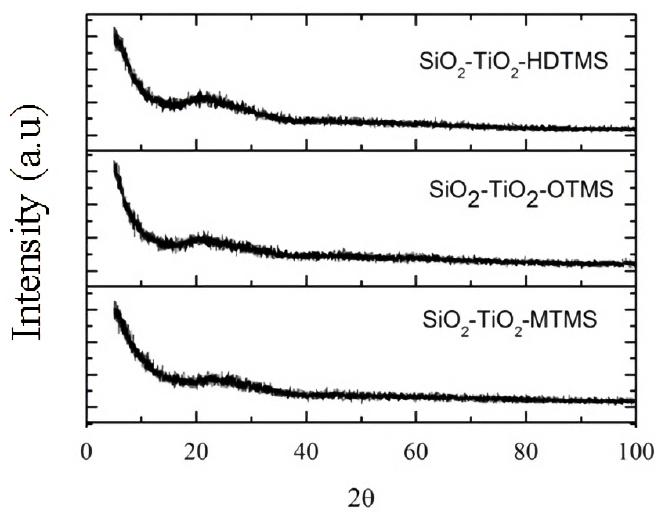
Figure 1. The XRD diffractogram of the samples.